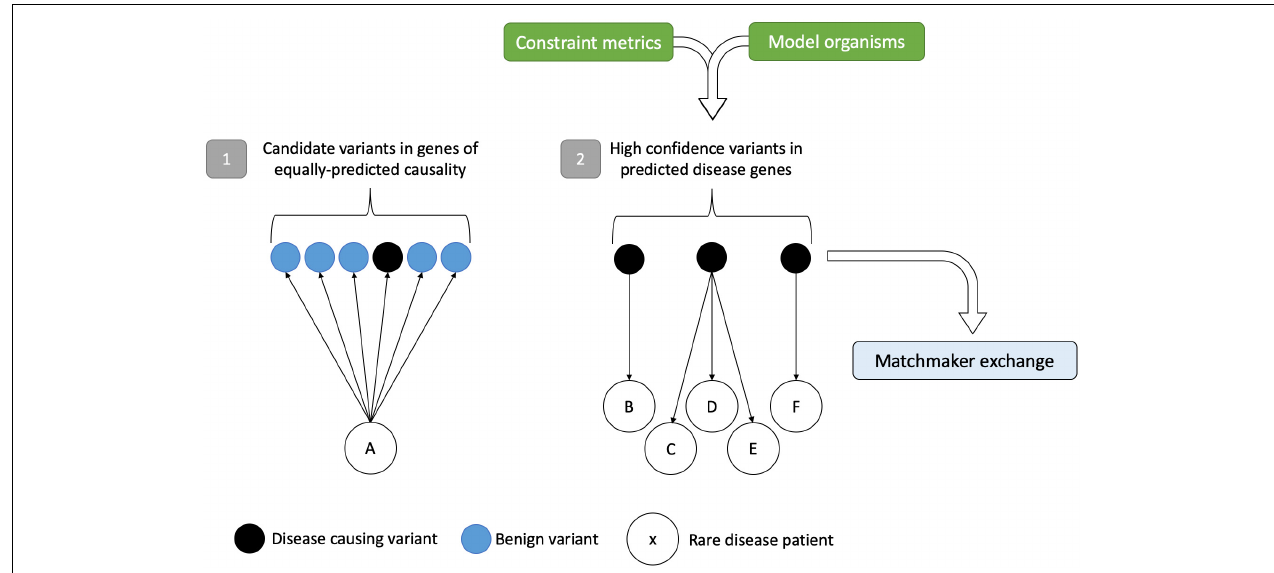
FIGURE 3 | Gene-to-patient approach for improved rare disease diagnostics. Scenario (1) shows a traditional patient-to-gene approach. Following variant analysis, rare disease patient A has several potential disease candidates, of which one (in black) is the disease-causing variant hidden within the sea of benign variation. Without prior knowledge that any of these variants are causative, the only way to test their pathogenicity is by expensive functional studies on genes of equally predicted causality. In scenario (2), the approach is reversed. High-confidence disease-causing variants in genes identified by constraint metrics and model organism data can be matched to patients and compared to clinical phenotypes, circumventing the analytical noise precluding variant interpretation. In turn, this identifies the best candidates for follow-up and for data sharing in the MME. Variants/genes that match to more than one patient with the same or overlapping phenotypes can add credence to the method. Figure adapted from Seaby and Ennis (2020).